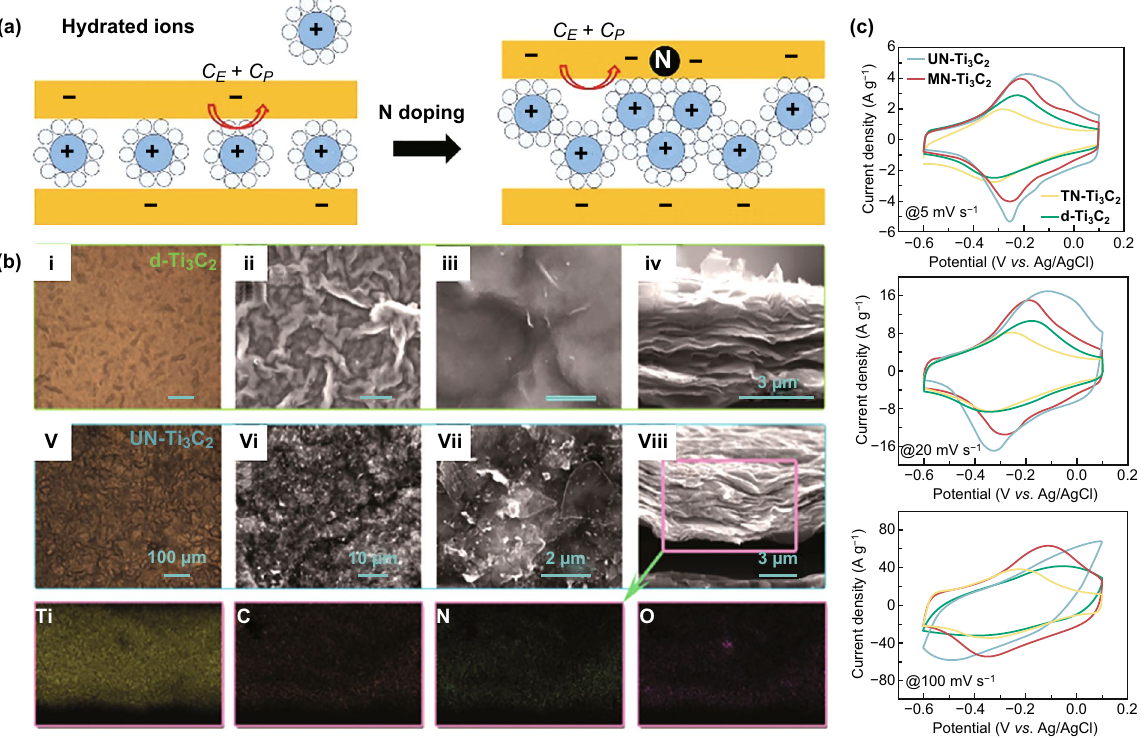
Fig. 10 N-doped Ti 3 C 2 T x . a Schematic illustration of charge storage of hydrated electrolyte ions in N-doped Ti 3 C 2 T x [122]. b Plan view of opti- cal and SEM images of Ti 3 C 2 and N-doped Ti 3 C 2 T x using urea as the nitrogen source (UN-Ti 3 C 2 ). c CV curves of the Ti 3 C 2 films and N-doped Ti 3 C 2 using different method, such as UN-Ti 3 C 2 , MN-Ti 3 C 2 (nitrogen source is monoethanolamine), TN-Ti 3 C 2 (solid solution method) [123]. Reproduced with permission from Refs. [122,